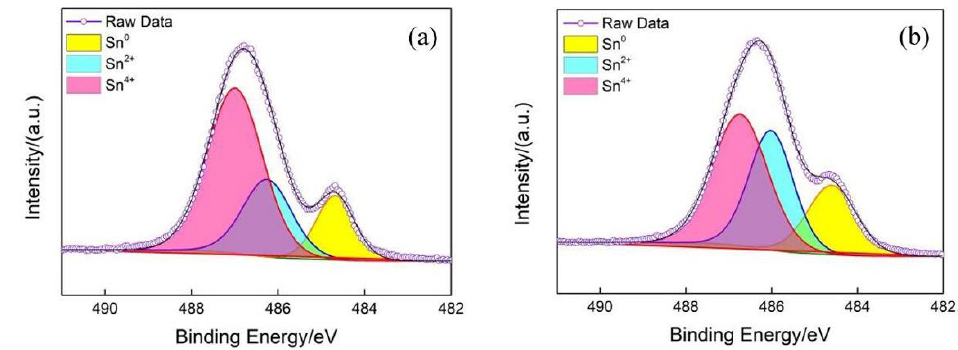
Figure 6. The XPS patterns of Sn 3d peaks for SAC305 solder ( a ) ball and ( b ) powder.